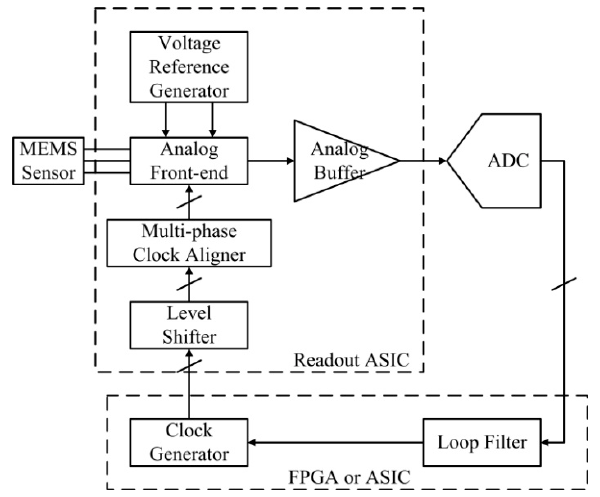
Figure 2. Structure of the closed-loop accelerometer with the proposed readout ASIC.